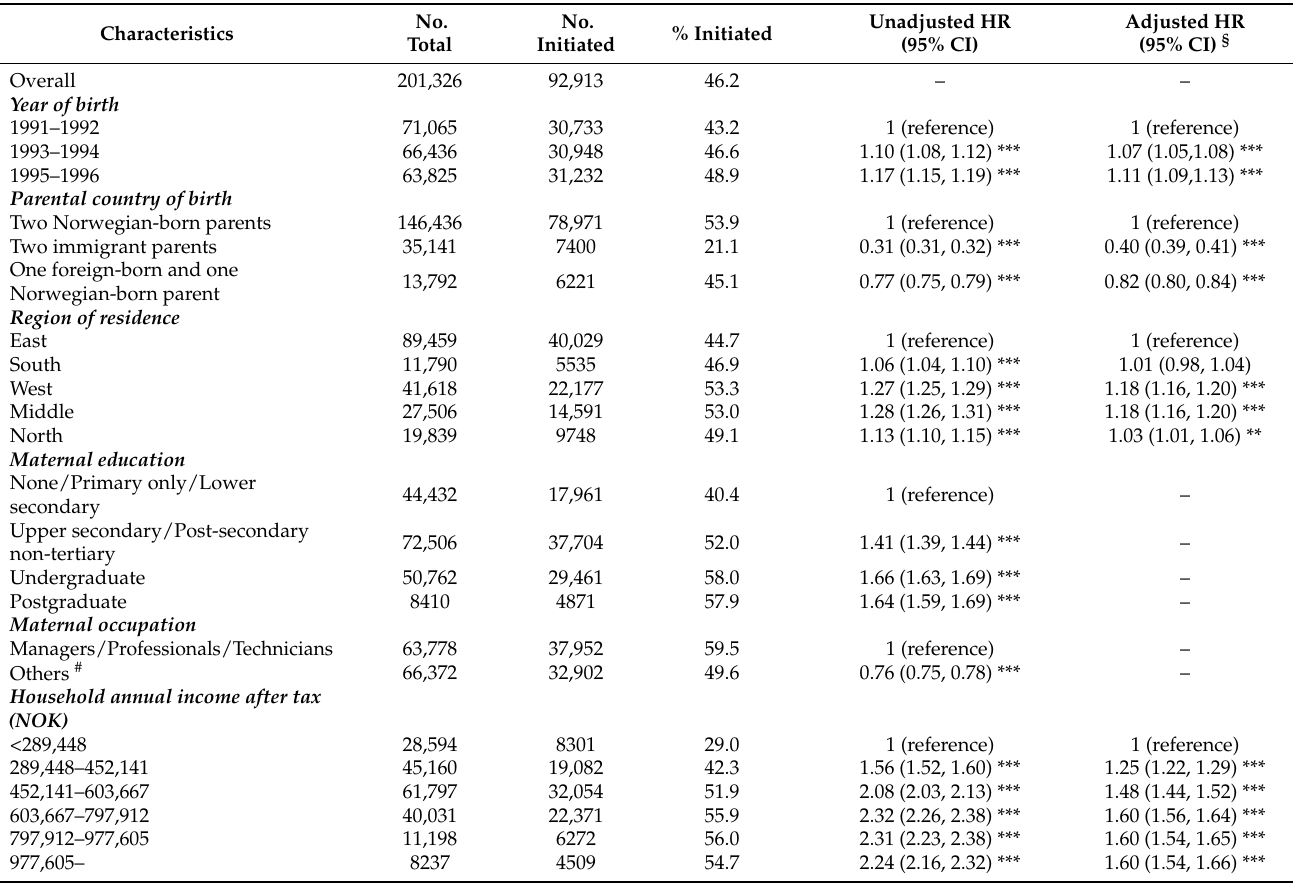
Table 3. Sociodemographic characteristics of HPV vaccination initiation from November 2016 to June 2018 among women eligible for catch-up HPV vaccination in Norway.